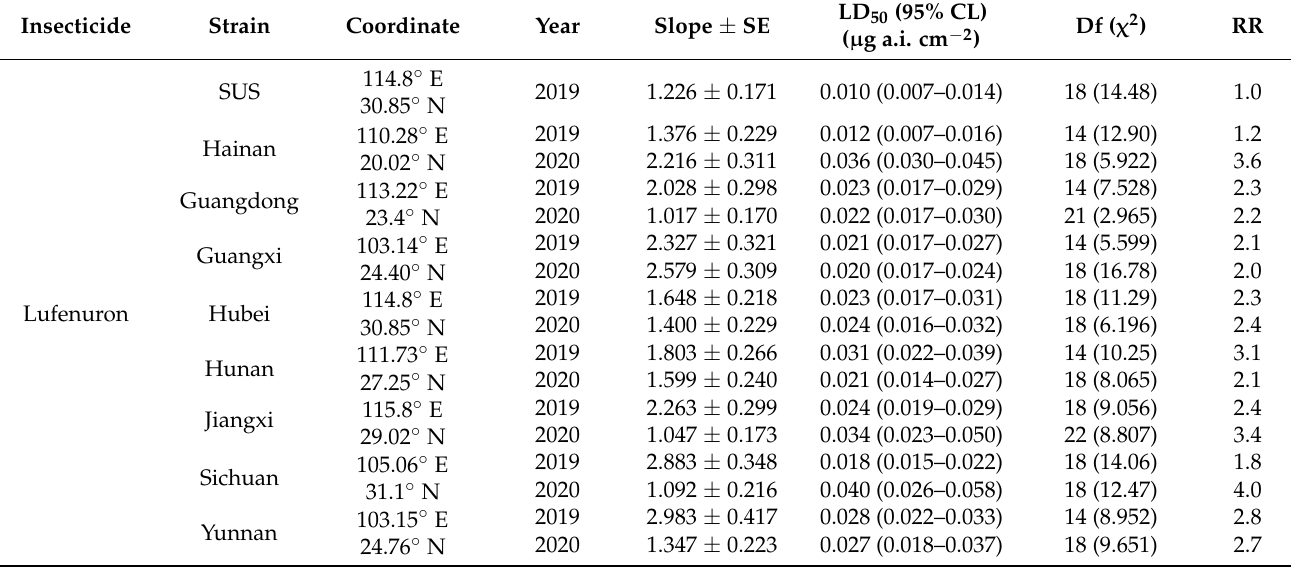
Table 2. Resistance levels of field population of S. frugiperda to lufenuron by diet-overlay bioassay. Insecticide Strain Coordinate Year Slope ± SE